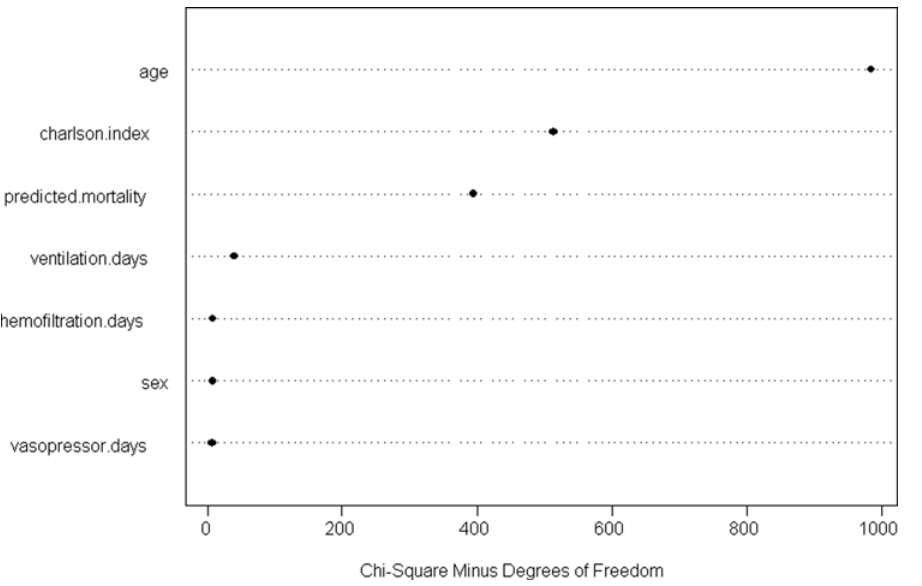
Figure 2. Contribution of each predictor in predicting the survival time in the Cox proportional hazards model.